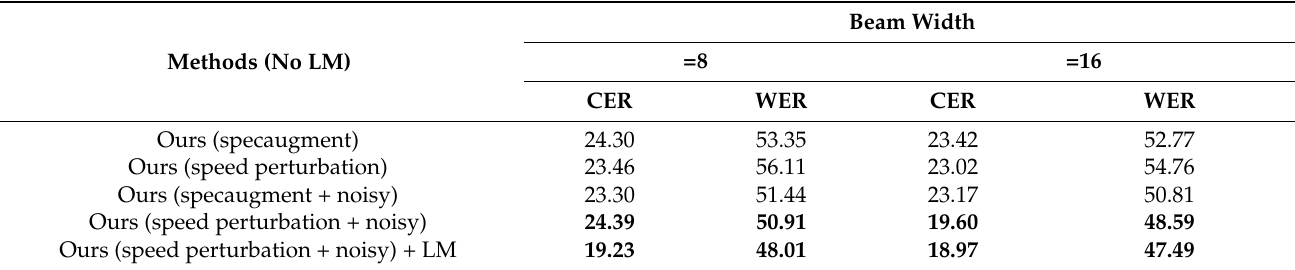
Table 8. Comparison of experimental results when the beam width is 8 or 16. Our experimental results are highlighted in bold (divided into two cases: with language model and without langu- age